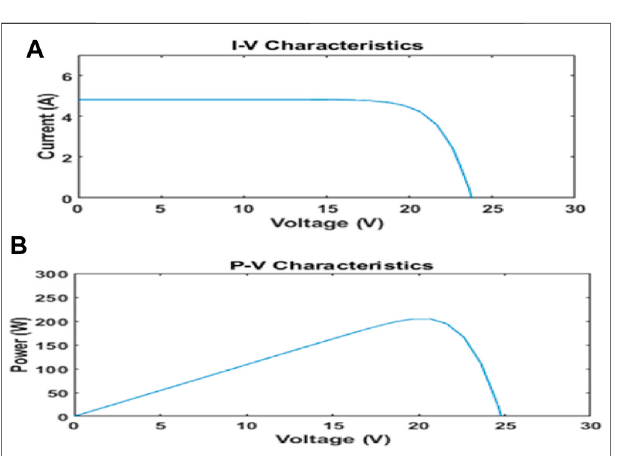
FIGURE 8 | Performance analysis of the PV power generation system.